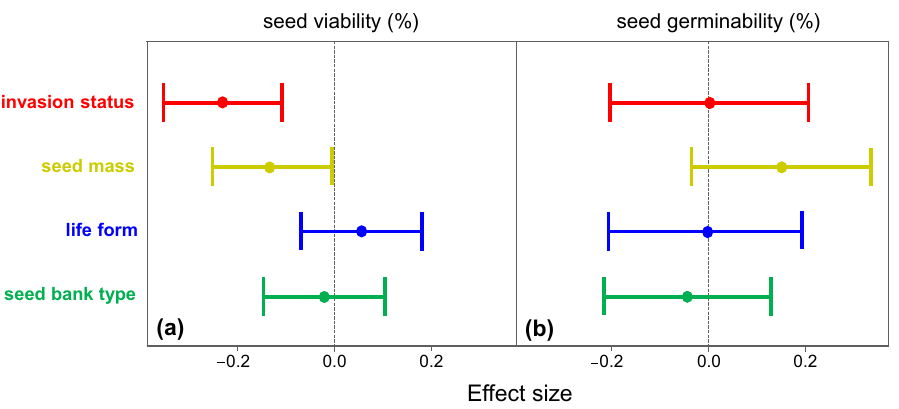
Figure 3. Effect of invasion status (invasive vs. naturalized), seed mass (log-transformed), life form (annual vs. perennial herb), and seed bank type (transient vs. persistent; GloSSBank 21 ) on ( a ) seed viability and ( b ) germinability. The effects are presented as posterior means and 95% confidence intervals and were analysed as fixed effects in phylogenetic logistic mixed models. Dashed lines indicate zero